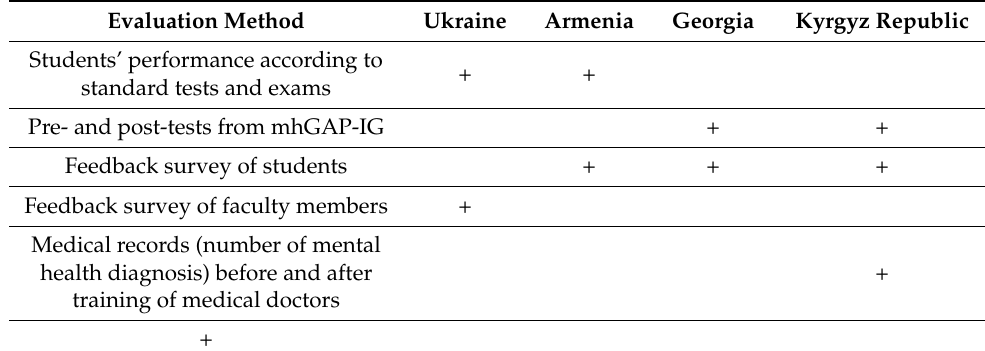
Table 4. Evaluation of mhGAP-IG